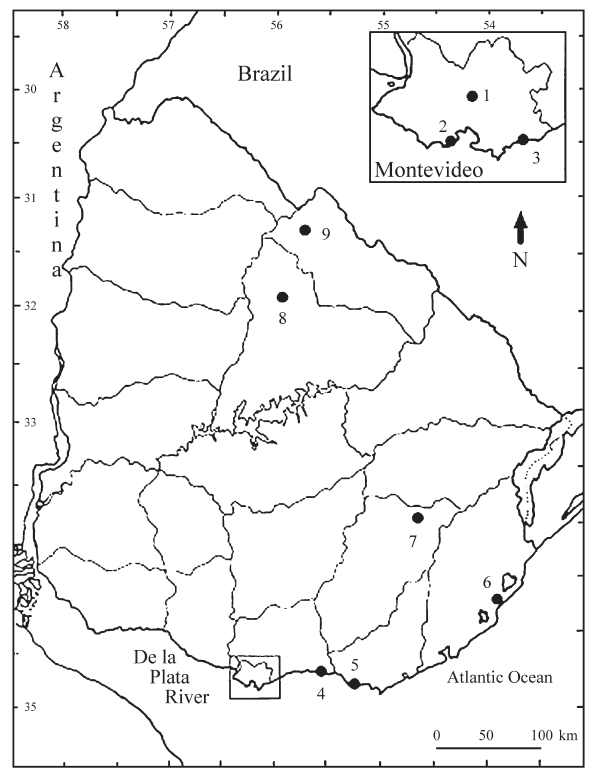
Figure1 - Drosophilawillistoni collectionsitesinUruguay.TheMontevi- deo district is shown in detail. Numbers refer to the collection sites indi- cated in Table